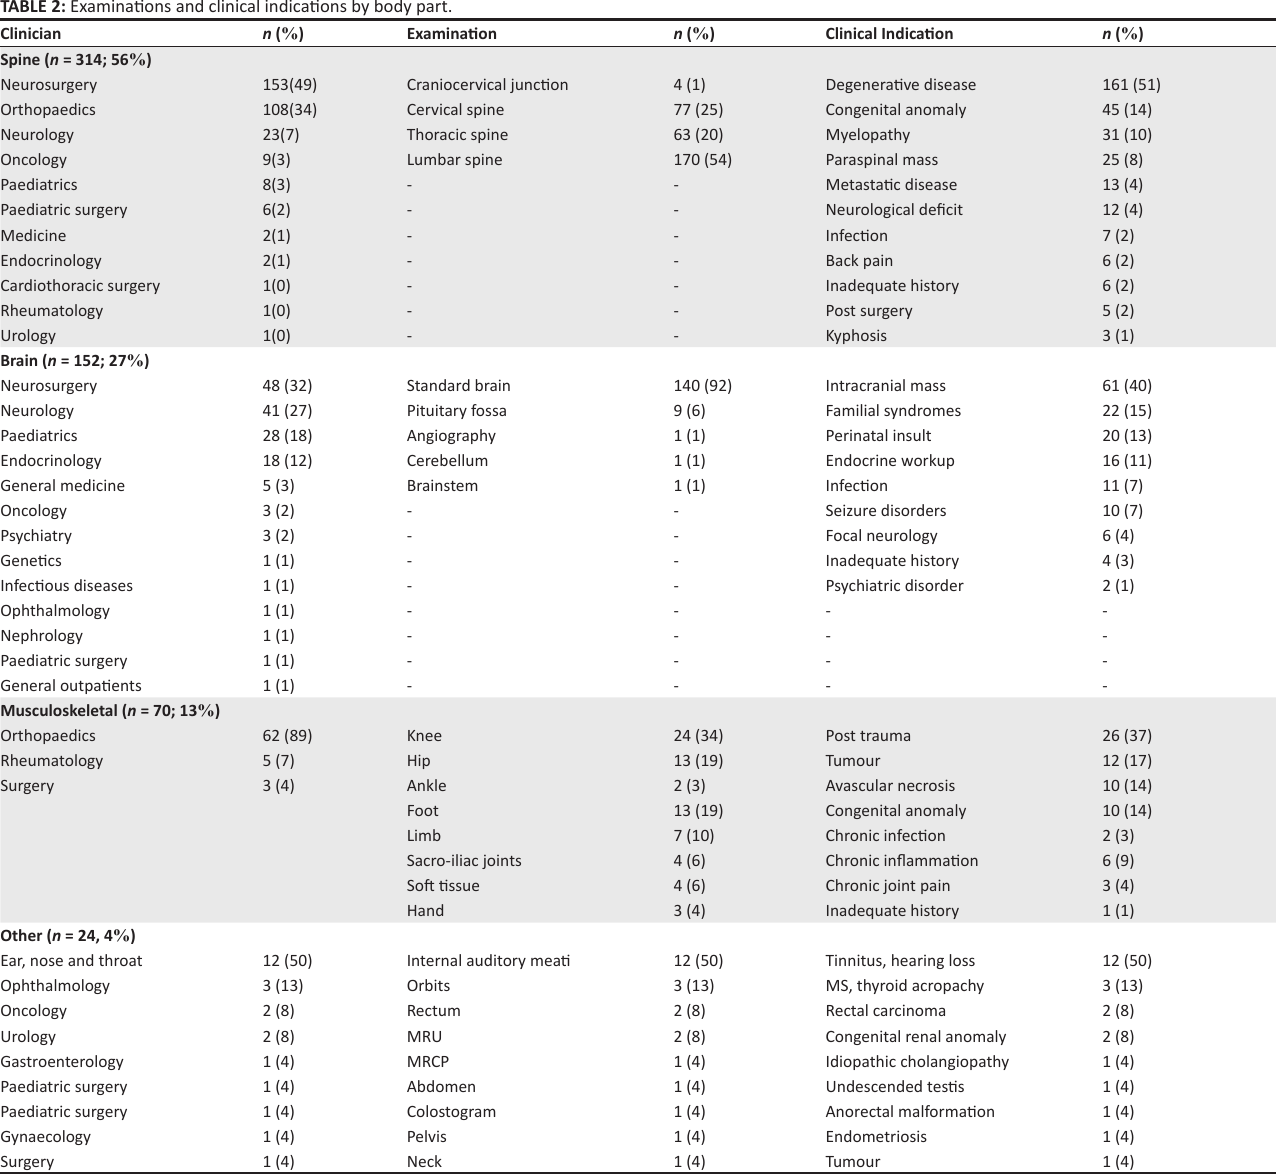
TABLE 2: Examinations and clinical indications by body